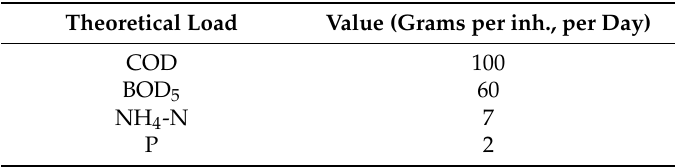
Table 2. Theoretical loads of physical–chemical parameters.